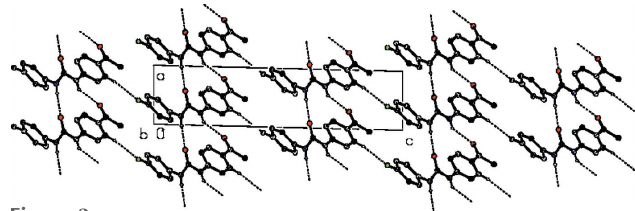
Figure 3 A view along the b axis of the crystal packing of the title compound. H atoms not involved in hydrogen bonding (dashed lines) are omitted for clarity.